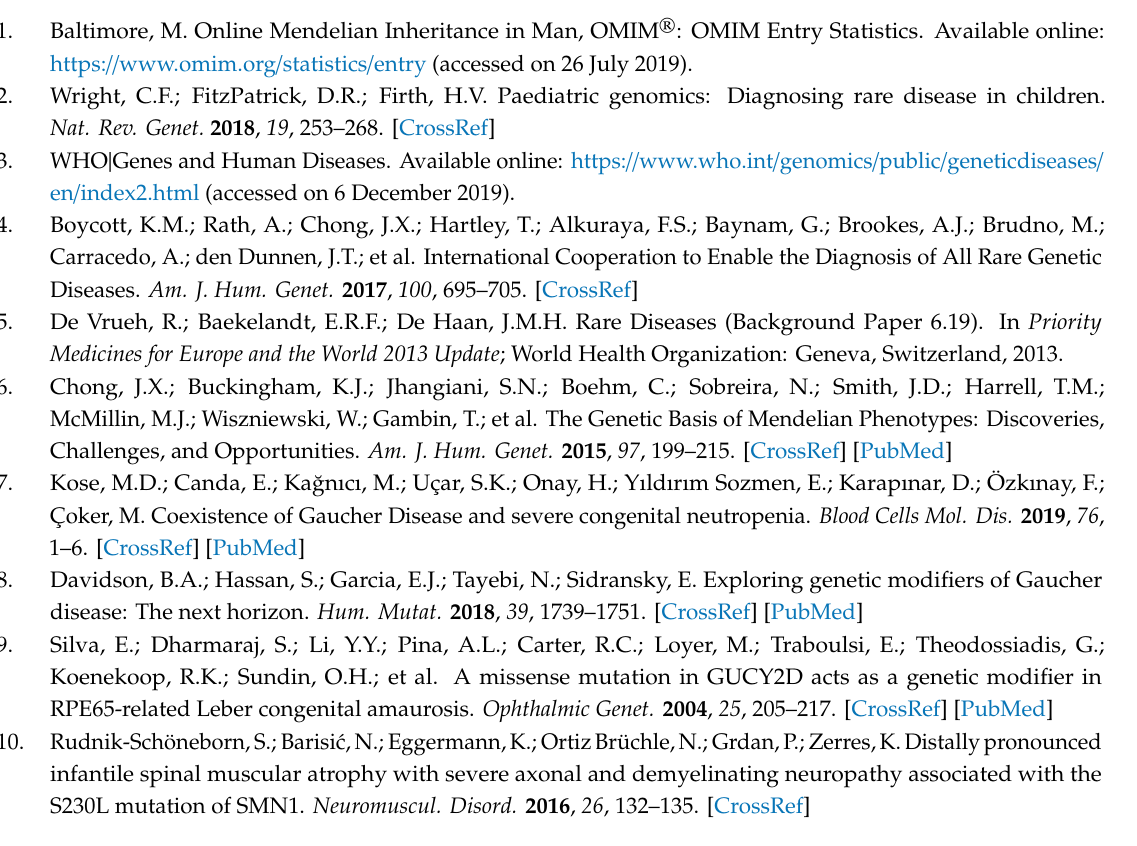
Figure S1: Schematic diagram of the literature review and the textual analysis process. Textual analysis is performed using NVivo 12